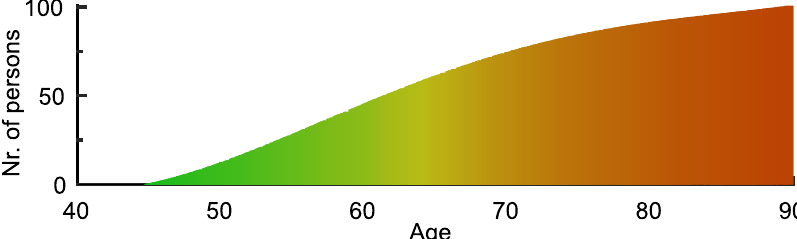
Fig. 1 Number of potential individuals with both ICA and PD as a function of age in the US. a Demographic of age distribution in the US (year 2000). b Probability of Parkinson ’ s disease (PD) in North America as a function of age. c Estimated number of potential individuals with both isolated congenital anosmia (ICA) and PD in the US general population according to age